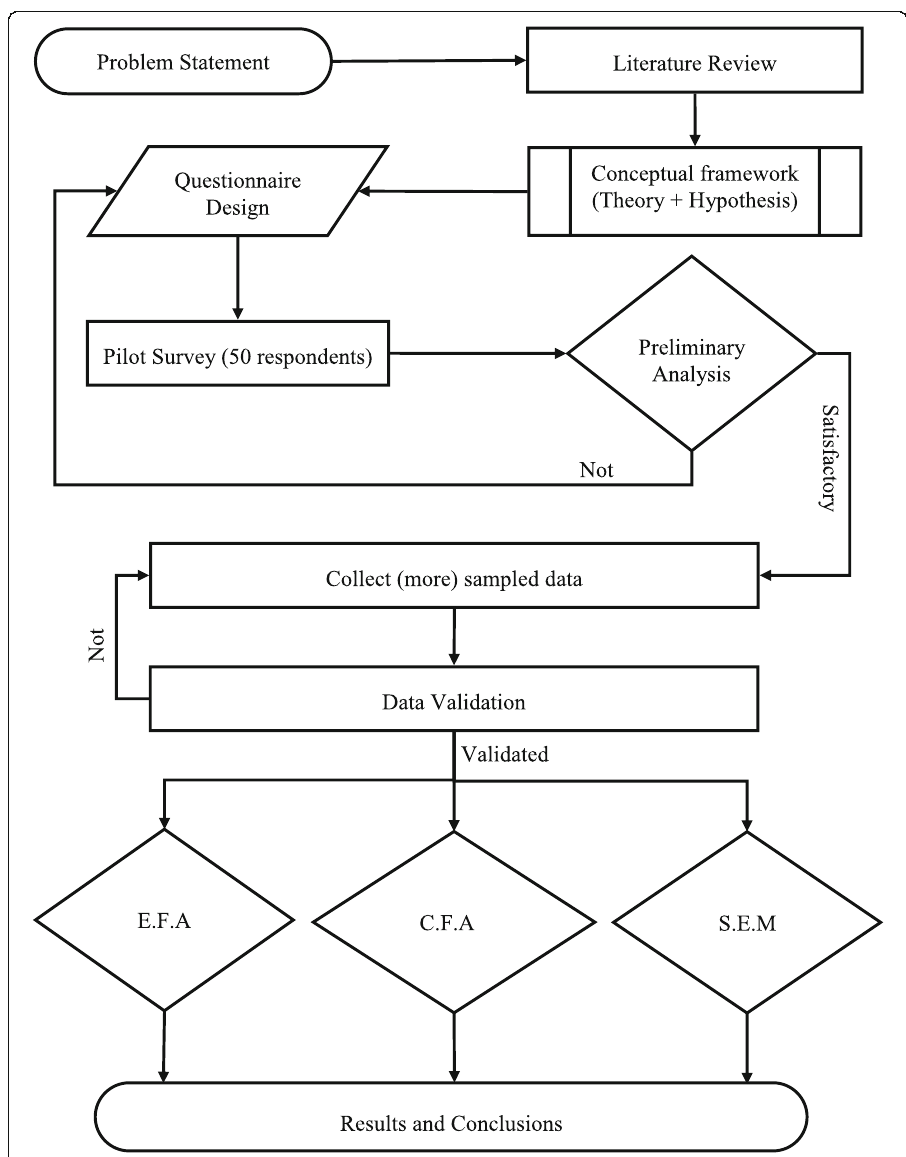
Fig. 2 Research methodology flow